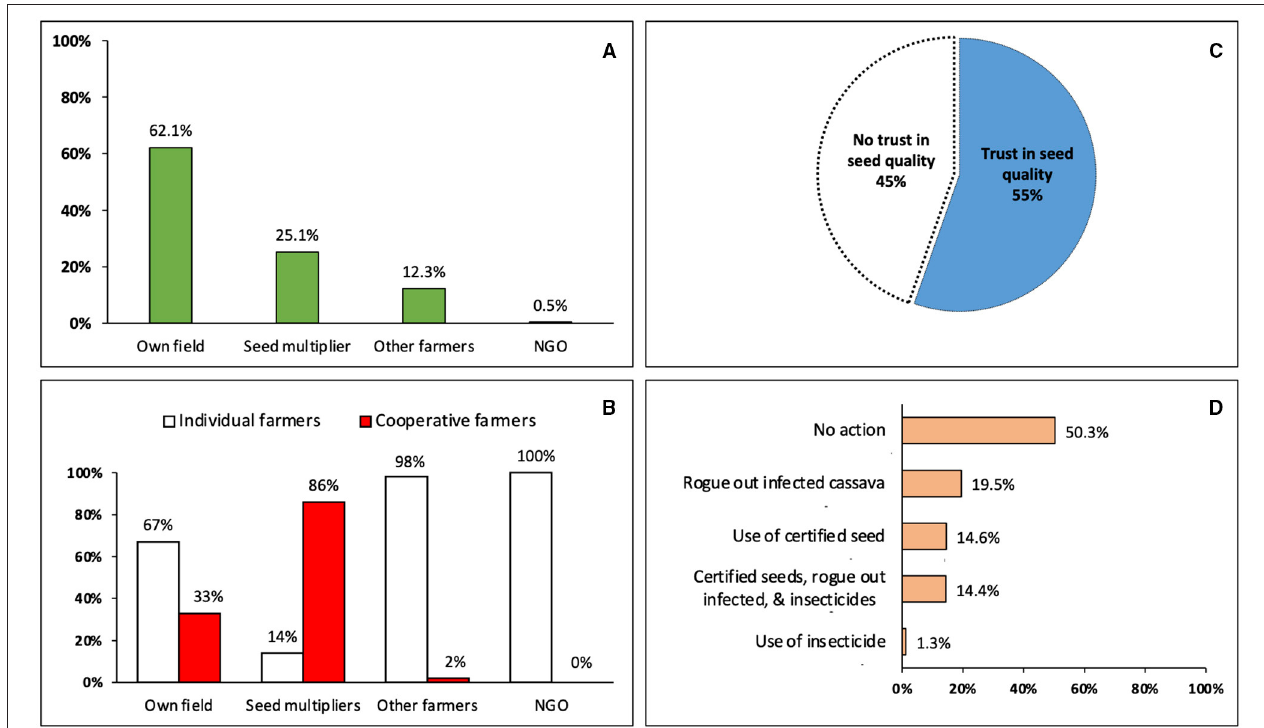
FIGURE 2 | Sources of cassava planting materials, trust, and disease management among farmers in Rwanda during 2019. (A) Sources of planting materials, (B) categories of farmers vs. sources of seeds, (C) level of trust in seed quality among participants, (D) disease management methods applied by participants (NGO, non-government organization).